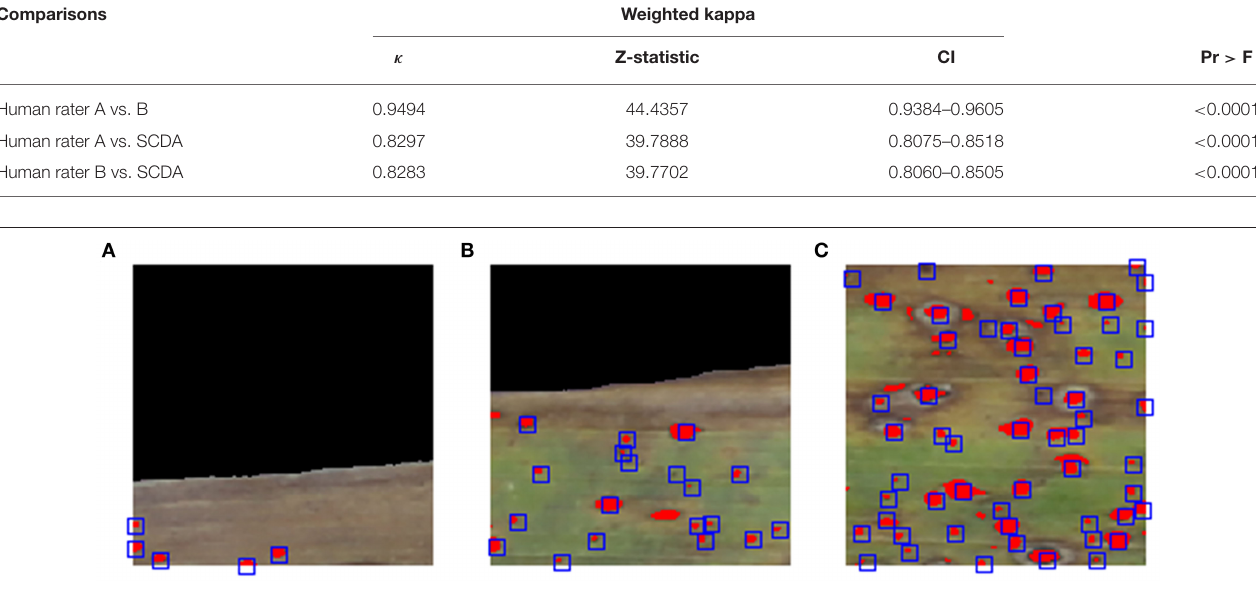
FIGURE 9 | Overview of evaluating spatial overlap of stromata recognized by human rater A and contour analysis. Illustration of evaluating random image blocks (A–C) , showing infected leaf image blocks with varying numbers of stromata (increasing frequency of stromata from left to right). Red blobs represent the area of stromata detected by contour analysis while the center of blue squares signifies the point which the human raters identified to be stromata.